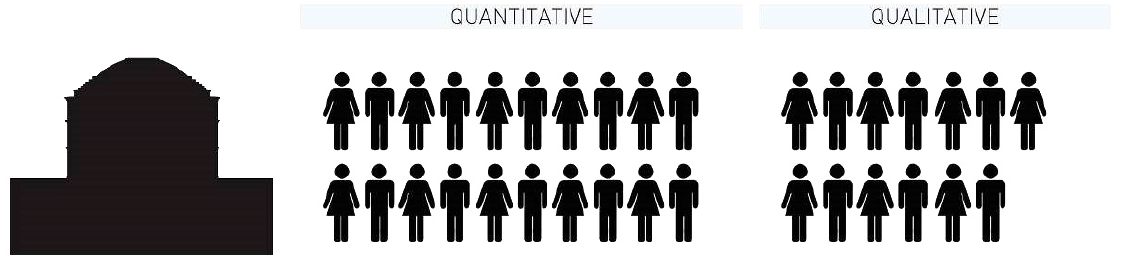
Figure 3. Graphical overview of available EAE survey responses deemed appropriate to include in the dataset for the Pantheon in Rome. This included both quantitative and qualitative data.